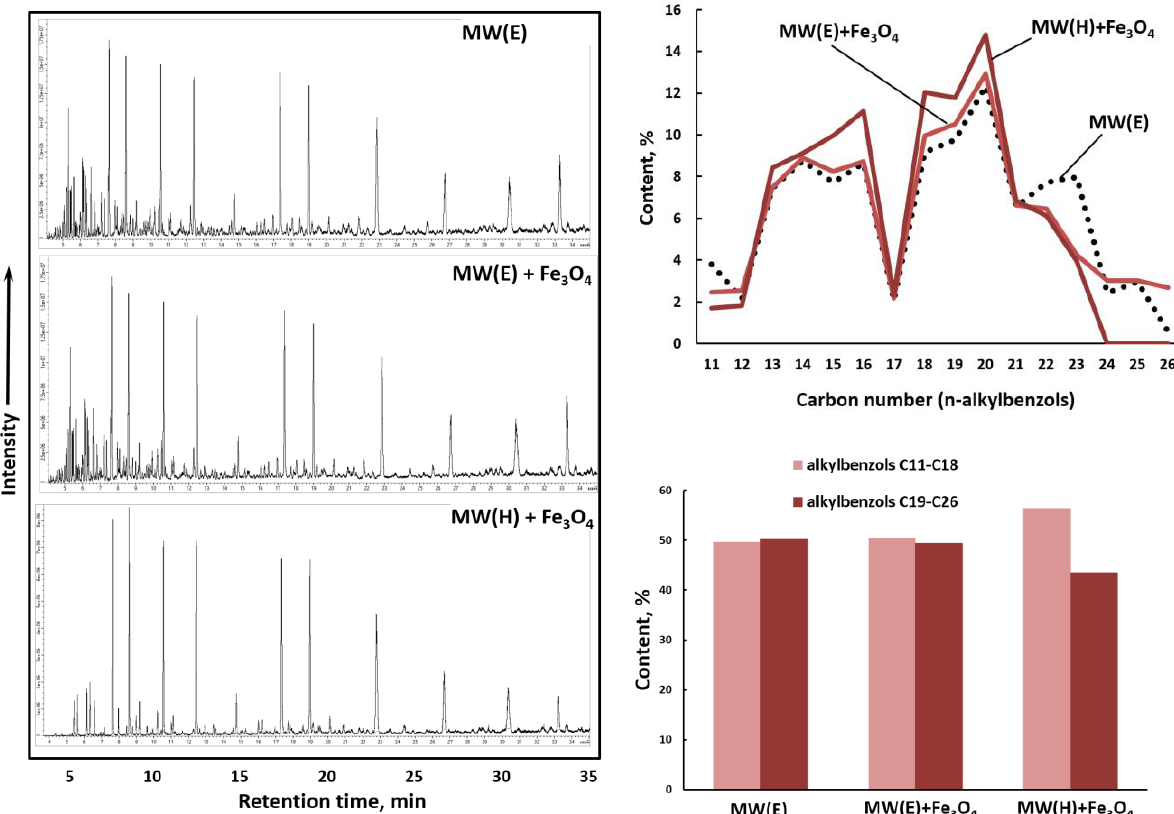
Figure 5. Chromatograms and relative contents of 1,3,4-trimethyl-2-alkylbenzenes in the aromatic fraction of oil samples after microwave exposure. In the lower-right corner is the ratio between long-chain and short-chain alkylbenzenes.